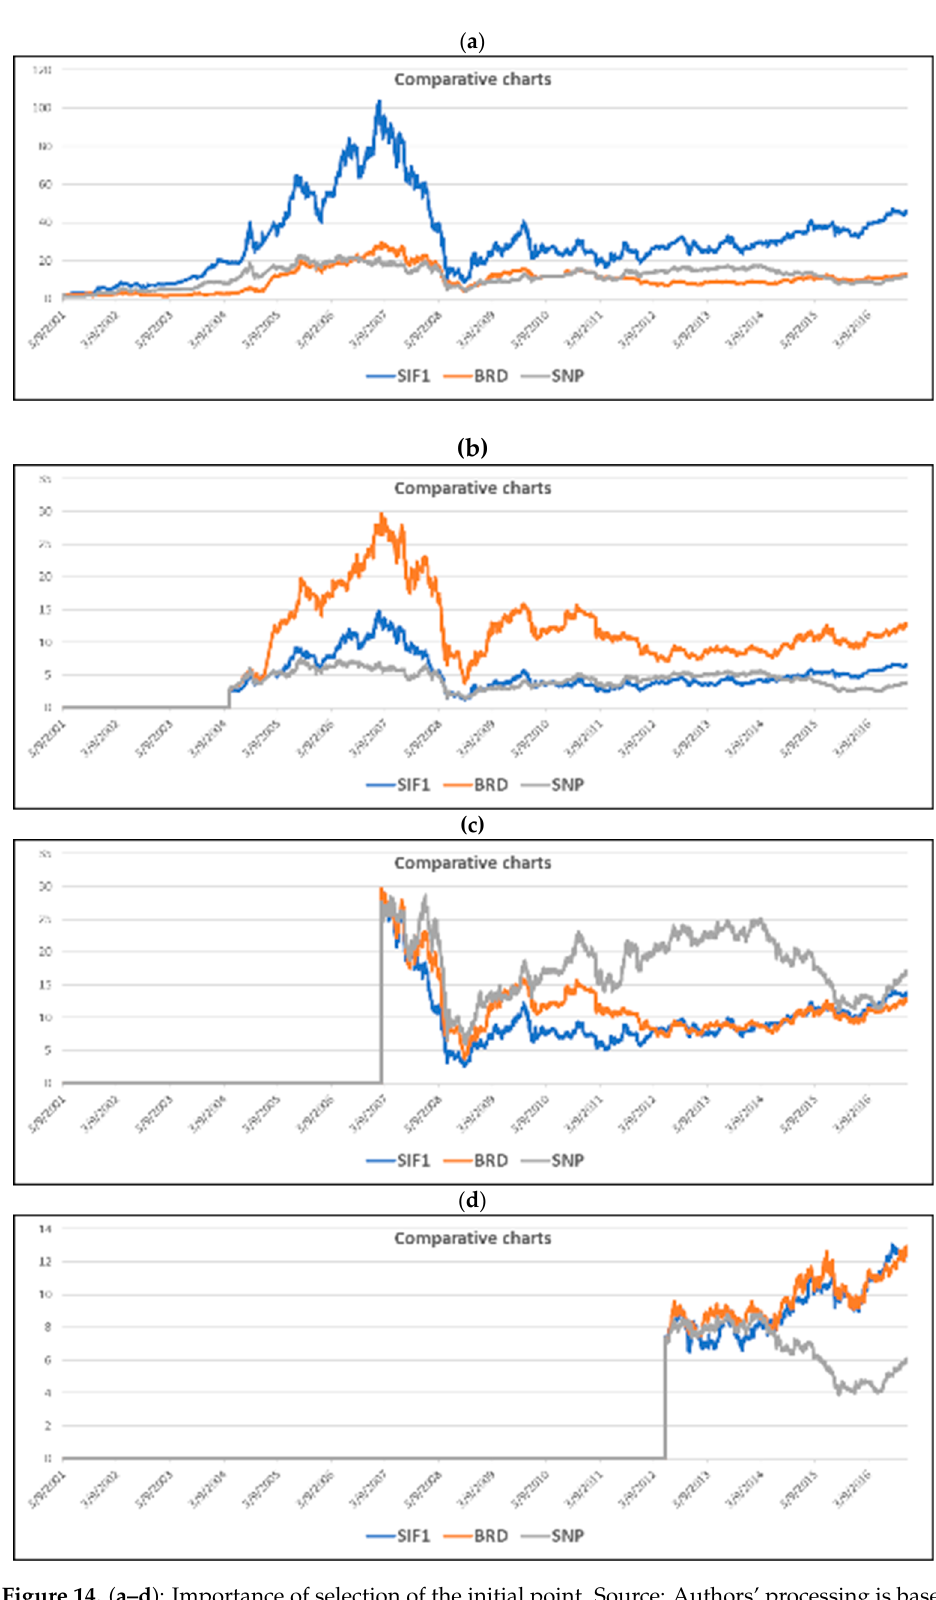
Figure 14. ( a–d ): Importance of selection of the initial point. Source: Authors’ processing is based on data available on www.bvb.ro (accessed on 12 February 2018).